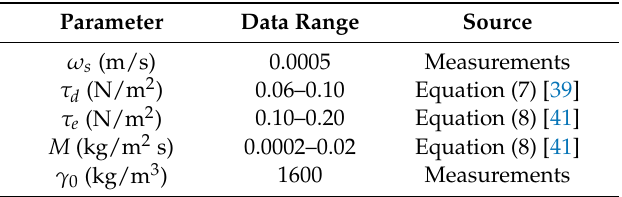
Table 4. Parameter setting in the model.